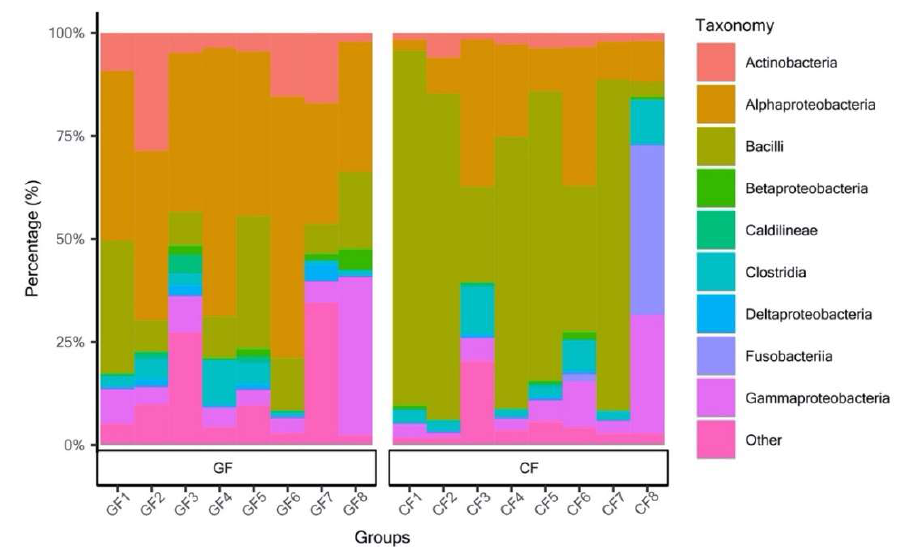
Figure 2. Relative abundances of the top 10 bacterial classes.